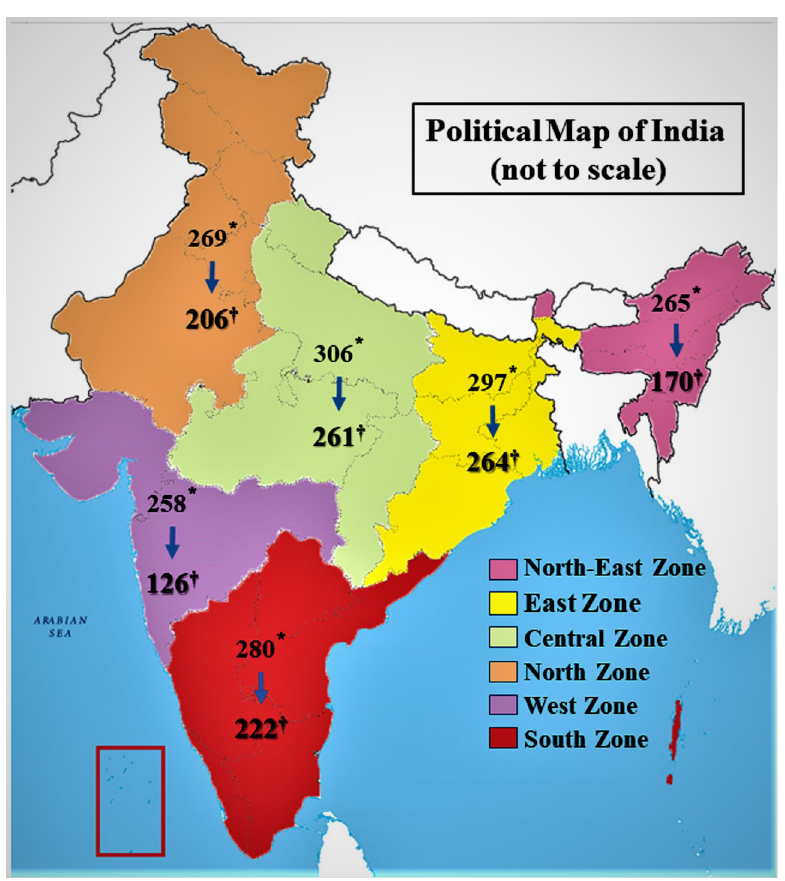
Fig 1. Sampling zones in India and participants selected from each zone. � indicates the number of participants in the respective zones (selected based on their digital profiles) who accessed the data collection form, † indicates who responded and submitted the form (includes those who moved from other zones and currently residing in a different zone, but not updated it their digital profile). For details of sample selection refer to S1 File.